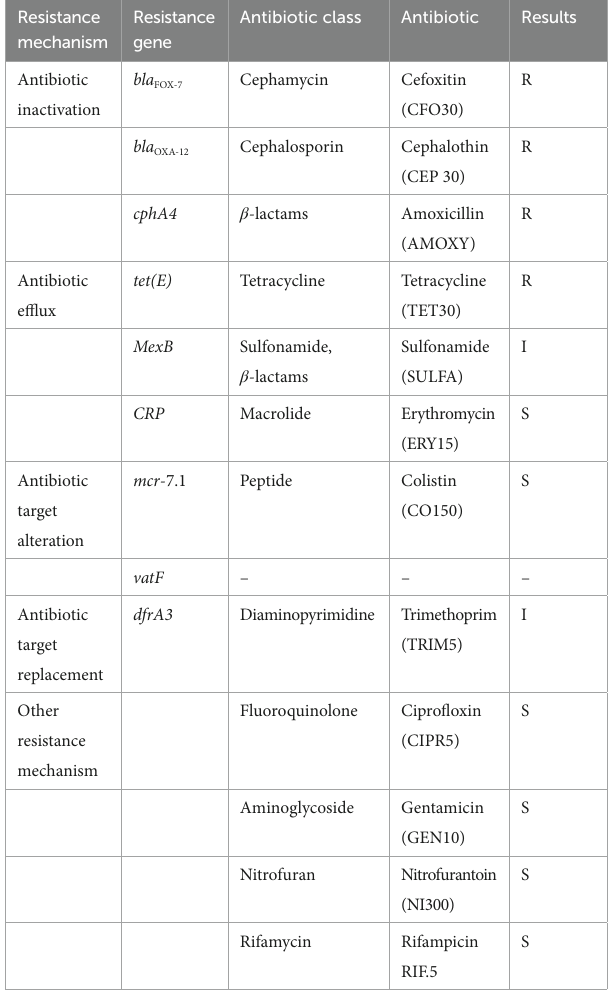
(Table 1). A volume of 100 μ l containing freshly cultured bacteria diluted at McFarland concentration of 10 8 CFU/ml was spread on Müller Hinton agar followed by putting the antibiotic discs on the bacteria lawn. Next, the plates were incubated at 30 ° C overnight followed by measuring the susceptibility or resistance based on the Clinical and Laboratory Standards Institute (CLSI) guidelines (Kahlmeter et al., 2006; Cockerill et al., 2012).